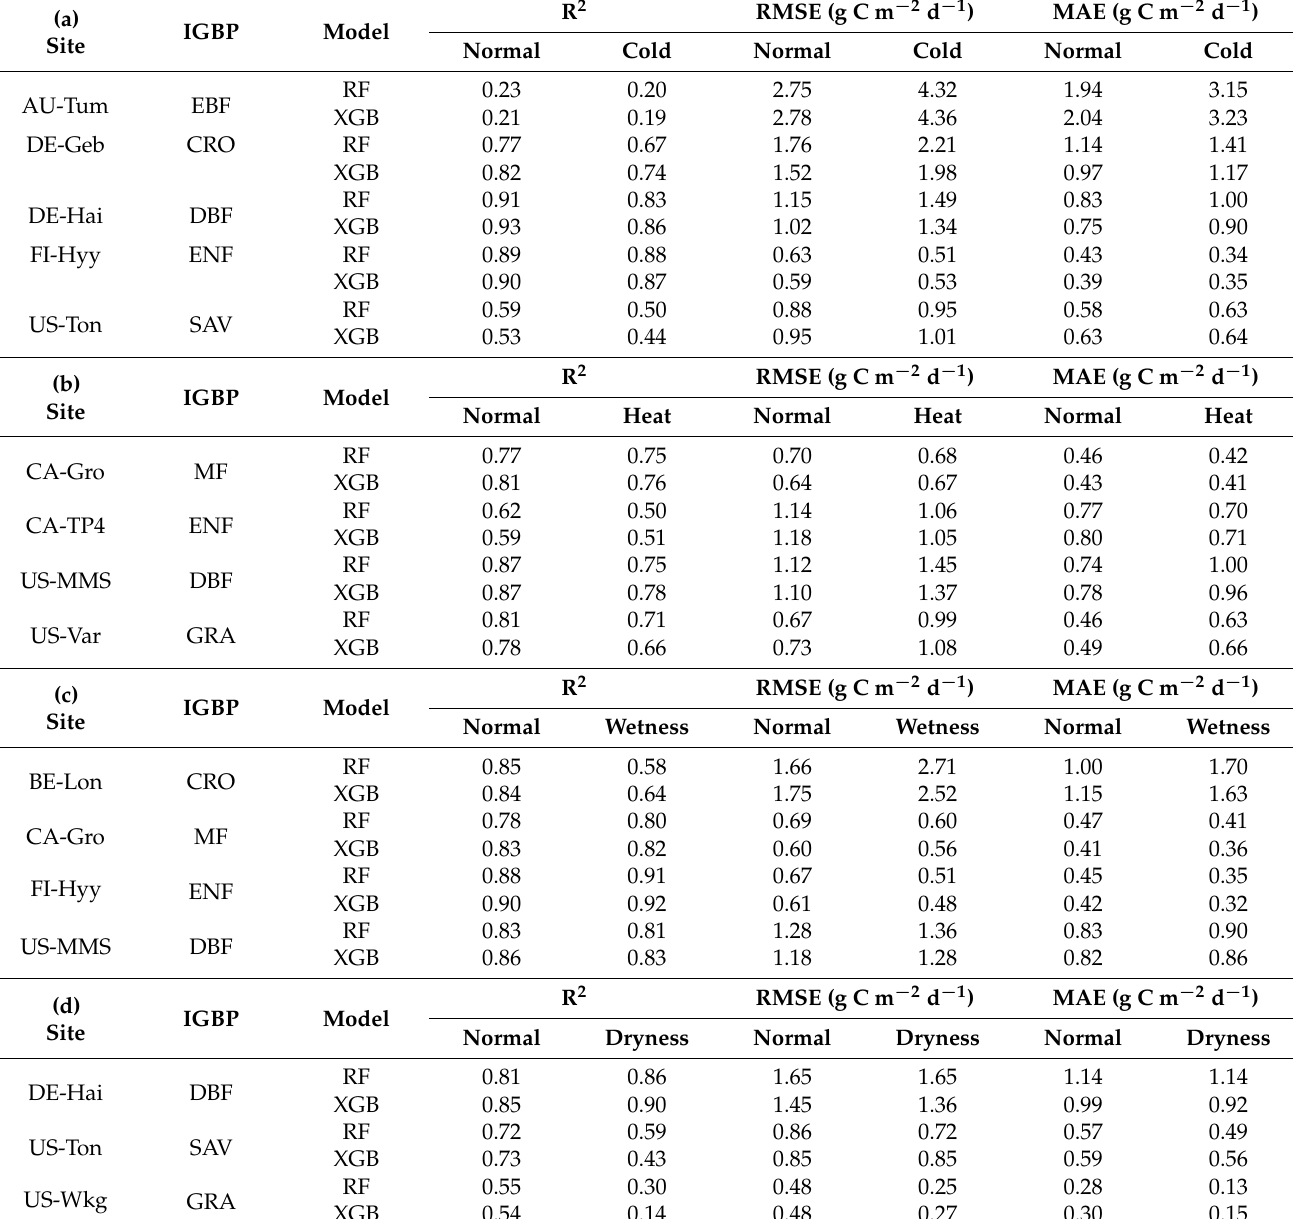
(R 2 = 0.86 for normal and R 2 = 0.83 for extreme). In the extreme dryness conditions, DBF (R 2 = 0.85for normal and R 2 = 0.90 for extreme) was not affected, but SAV (R 2 = 0.73 for normal and R 2 = 0.43 for extreme) and GRA were evaluated with significant decreases com- pared to the normal condition, especially the effect for GRA was considerable (R 2 = 0.54 for normal and R 2 = 0.14 for extreme) (Table 4). Table 4. Comparative analysis of NEE predicted by the RF and XGBoost in extreme climate conditions, (a–d) denote extreme cold, extreme heat, extreme wetness, and extreme dryness, respectively. Normal refers to the evaluation of the non-extreme samples. The screening method for each extreme site and year is described in Section